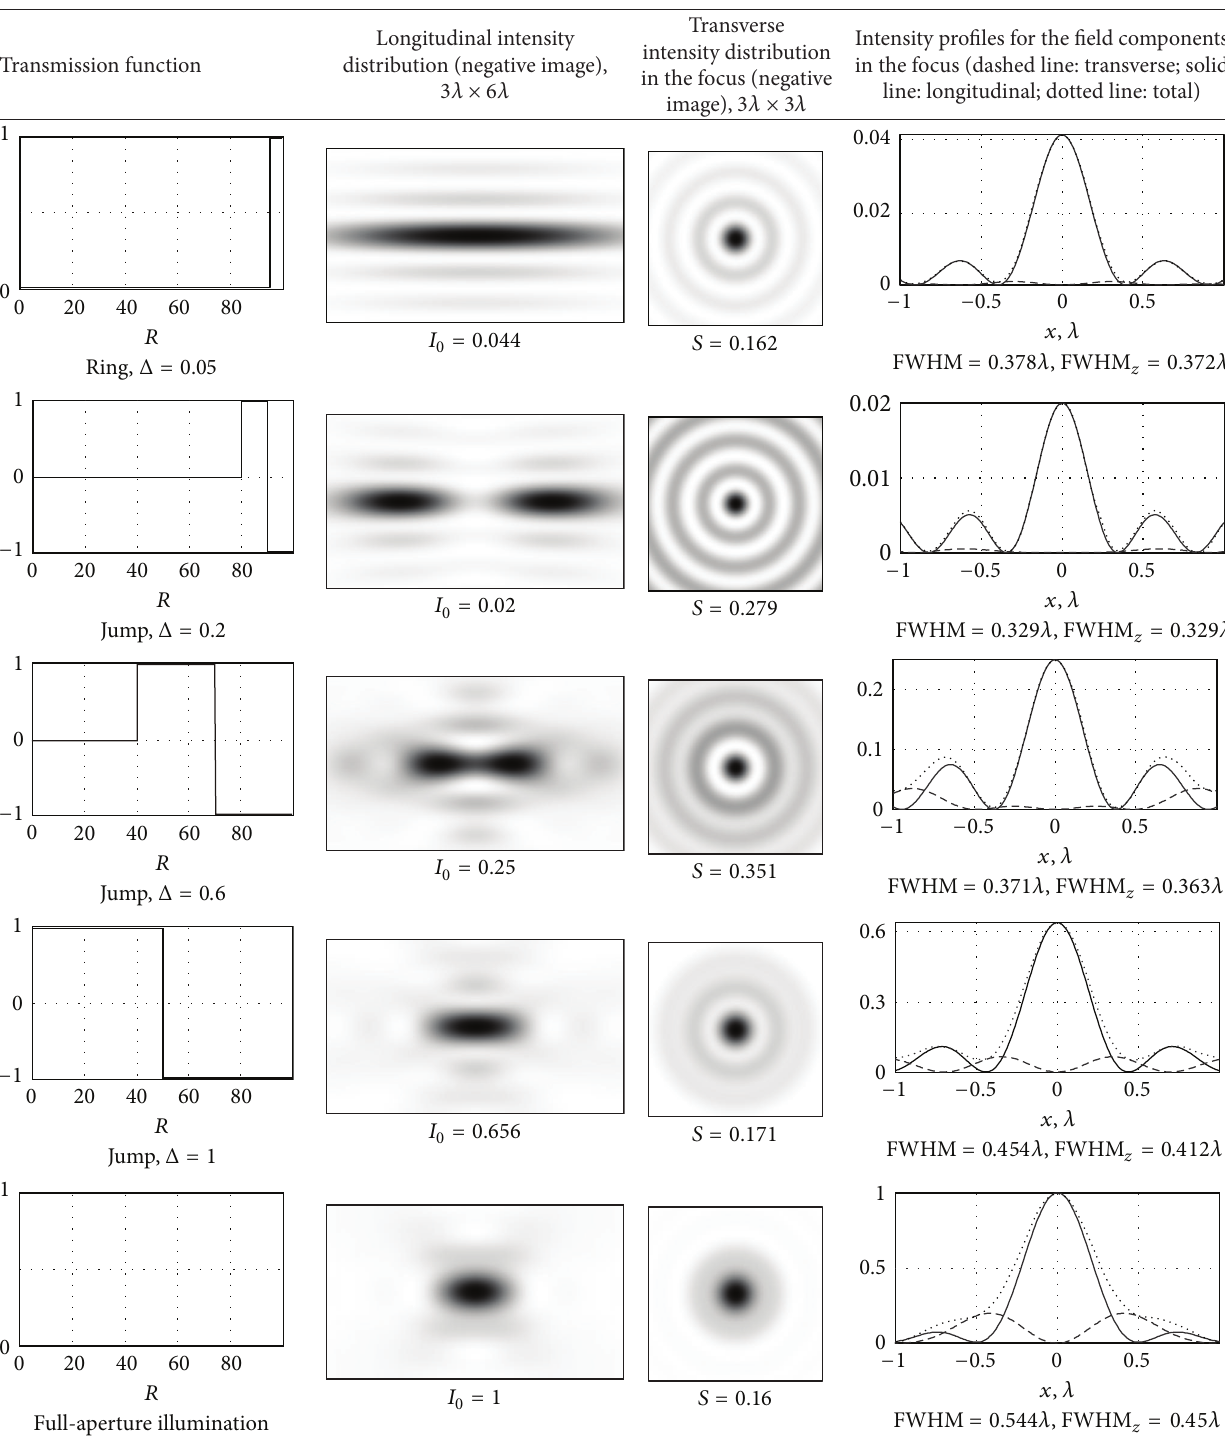
Table 1: Numerical simulation